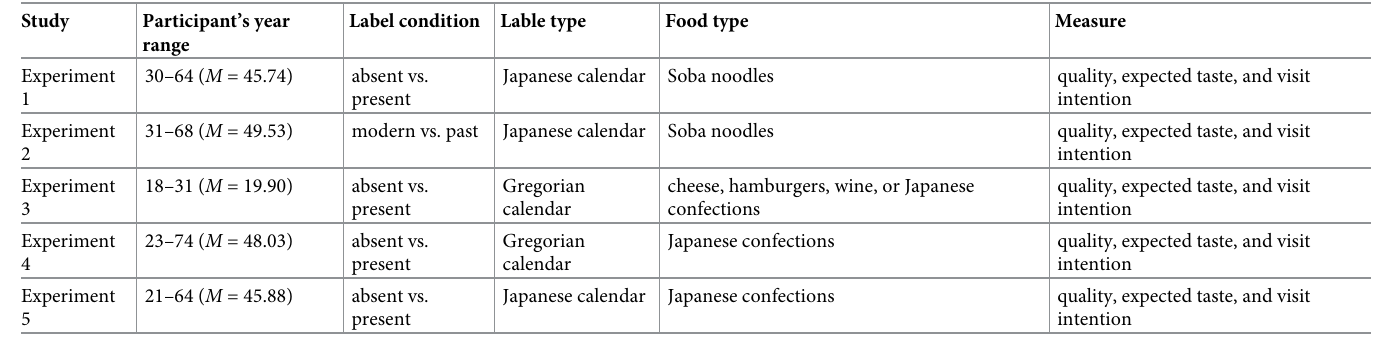
Table 1. Summary of experimental conditions.